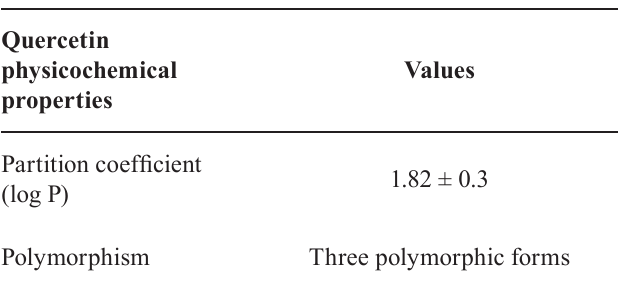
TABLE II - Physicochemical properties of quercetin (Kumar et al. 2014)